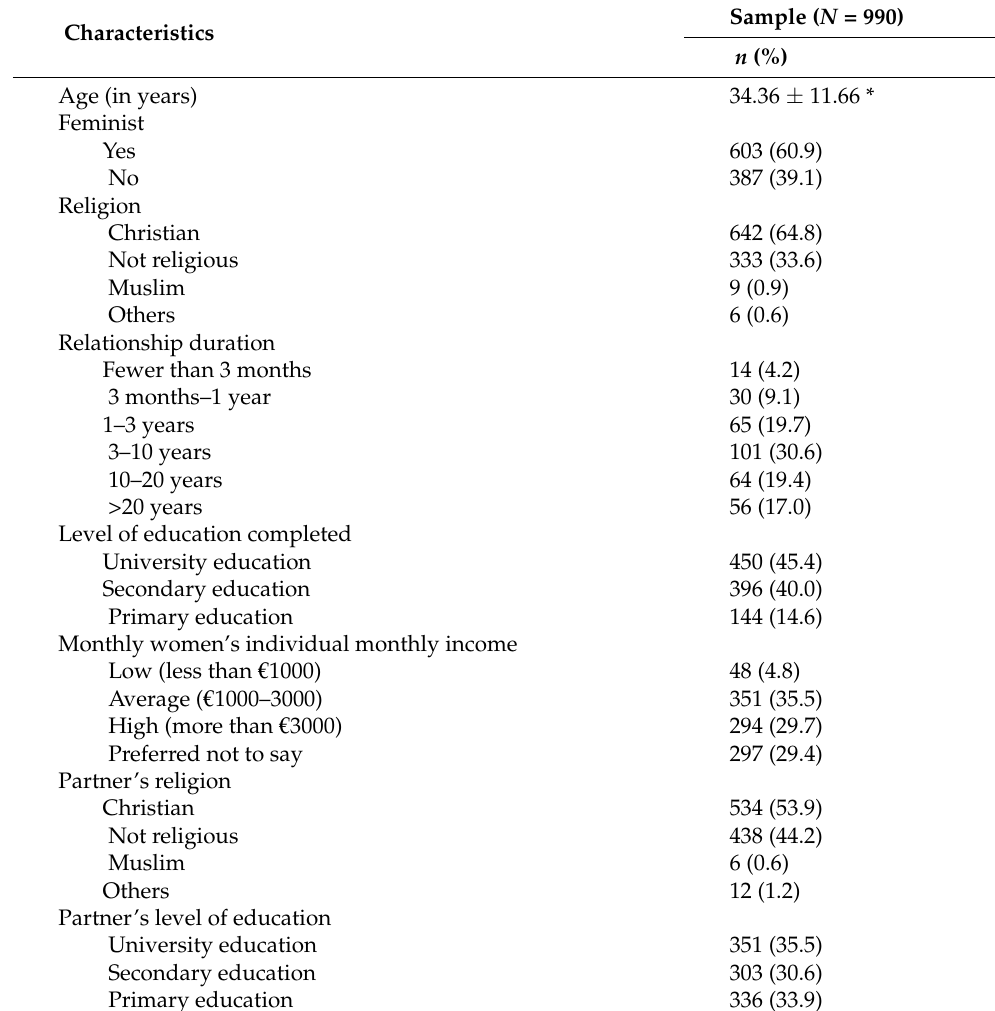
Table 2. Sociodemographic information from the participants in the final validation study ( N = 990).